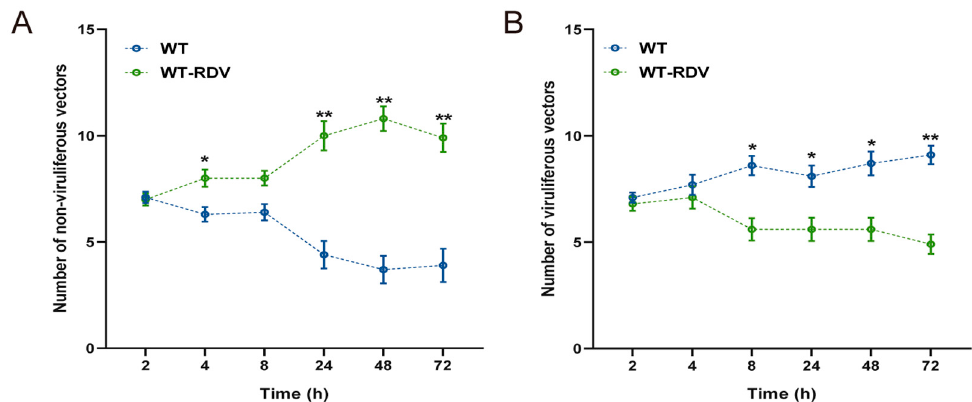
Figure 1. Feeding preference of non-viruliferous ( A ) and viruliferous N. virescens ( B ) between WT and WT-RDV rice plants. RDV, rice dwarf virus; WT, wild type (Minghui63, MH63) (RDV-free);